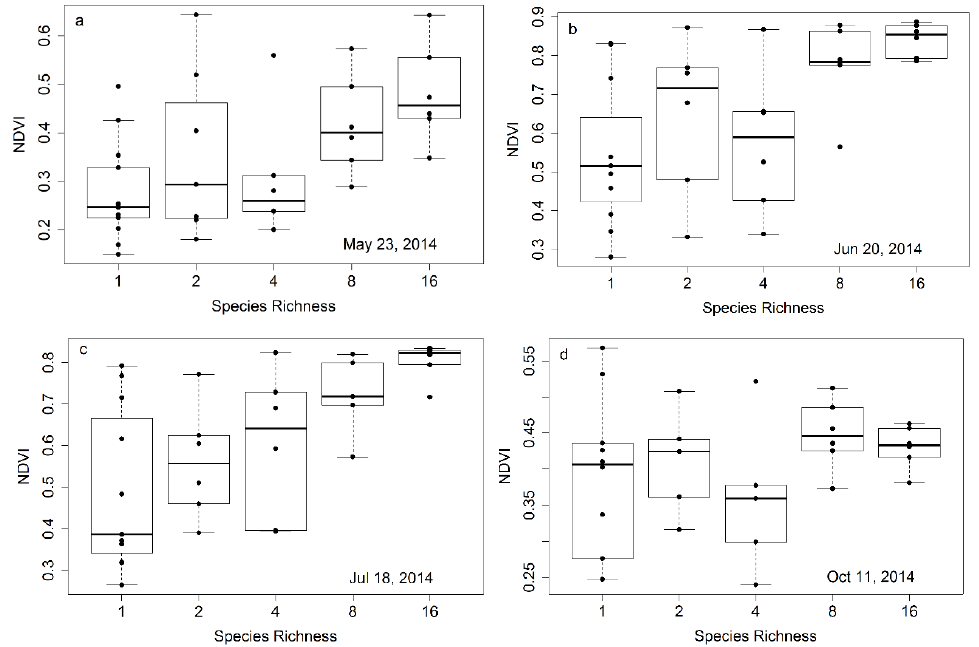
Figure 6. Representative examples of NDVI versus species richness at four time points (plots a – d ) in the 2014 growing season. These figures were derived from plot subsamples (17 measurements along the north most row of each plot) for 35 plots. Species richness represents the planted number of species per plot. Each richness treatment had a sample size of 6, except monoculture plots, which had a sample size of 11. In this figure, box plots were overlaid on actual data points (dots) that represent the average values for each plot. The regression statistics are provided in Table 1.